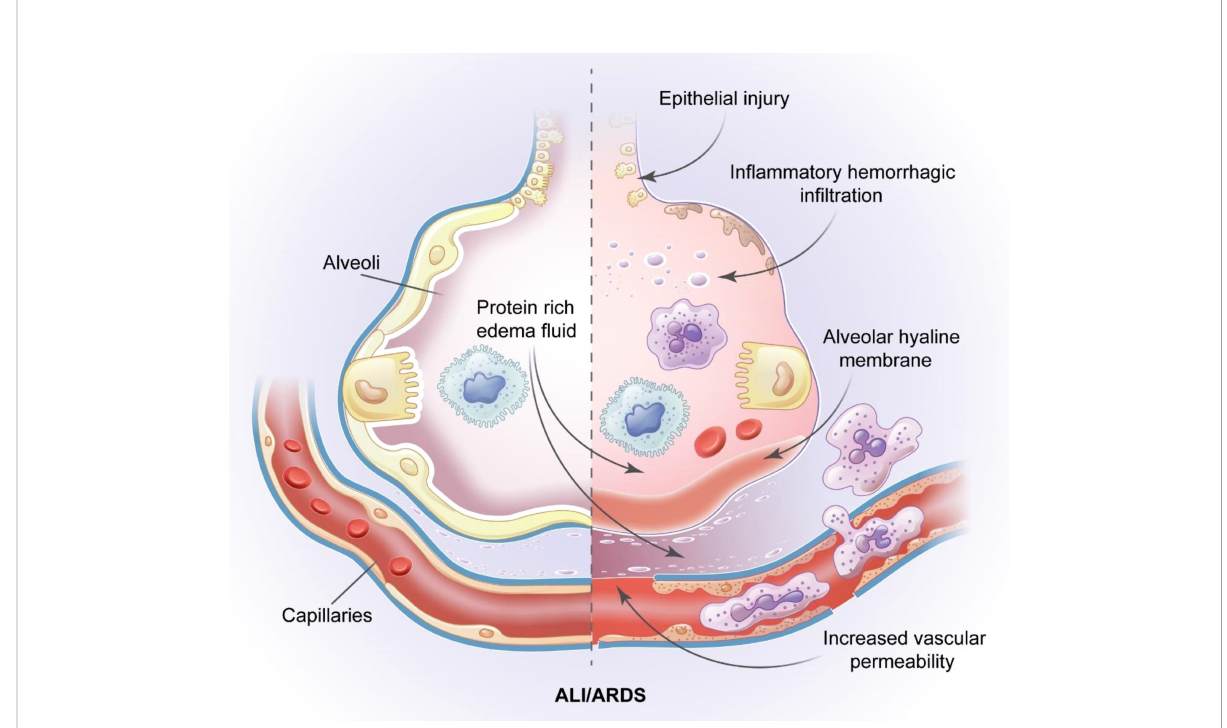
FIGURE 1 Pathological features of ALI/ARDS. The pathology of ALI/ARDS is characterized by diffuse alveolar capillary endothelial cells and epithelial cells necrosis, increased permeability of the pulmonary capillary endothelial cells and alveolar epithelial cell barriers, accumulation of protein rivh edema fl uid, extensive pulmonary hemorrhagic changes and alveolar hyaline membrane and intracapillary